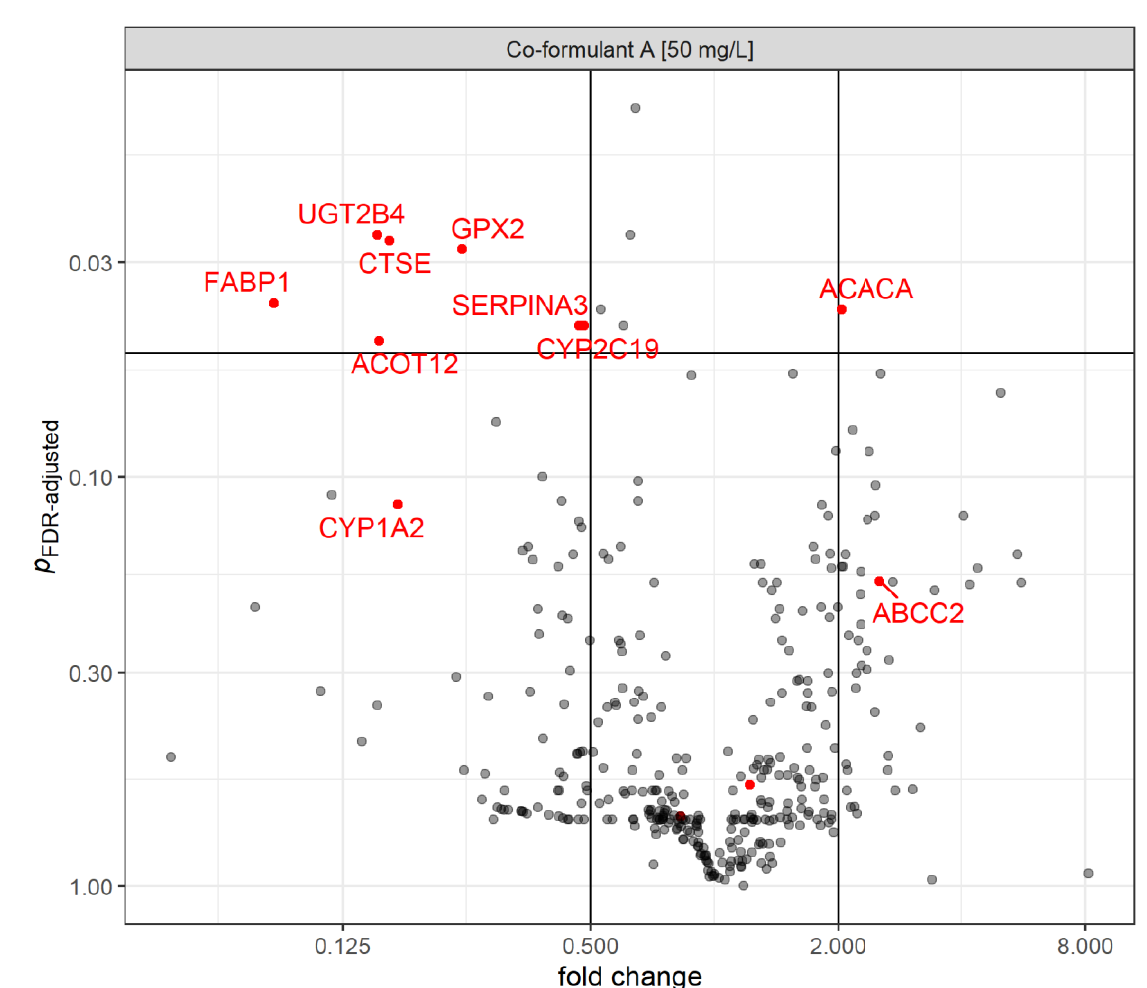
Figure 4: Gene expression changes (fold change) in HepaRG cells as a result of the 24 h treatment with co-formulant A of Adexar ® (50 mg/L) in comparison to the solvent control. Up and downregulation was considered relevant at <0.5 and >2-fold change in gene expression with significant gene transcripts indicated in red and labeled with gene symbols. P-values are adjusted by FDR-method (Benjamini and Hochberg, 1995). n=3 technical